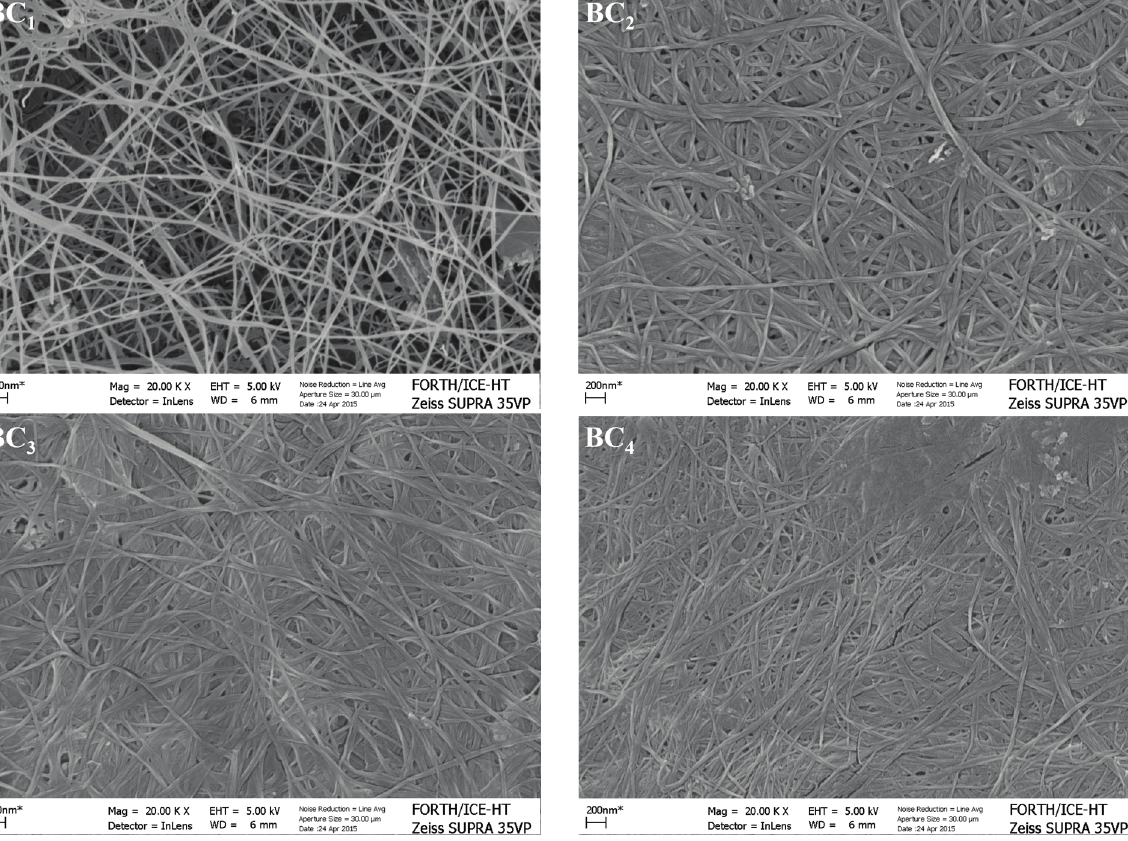
Figure 5. SEM images of BC samples that were produced using different fermentation media. BC 1 , crude glycerol combined with glucose-free HS medium; BC 2 , crude glycerol combined with SFM hydrolysate medium; BC 3 , HS medium; and BC 4 , FRW hydrolysate medium (all micrographs correspond to 20k